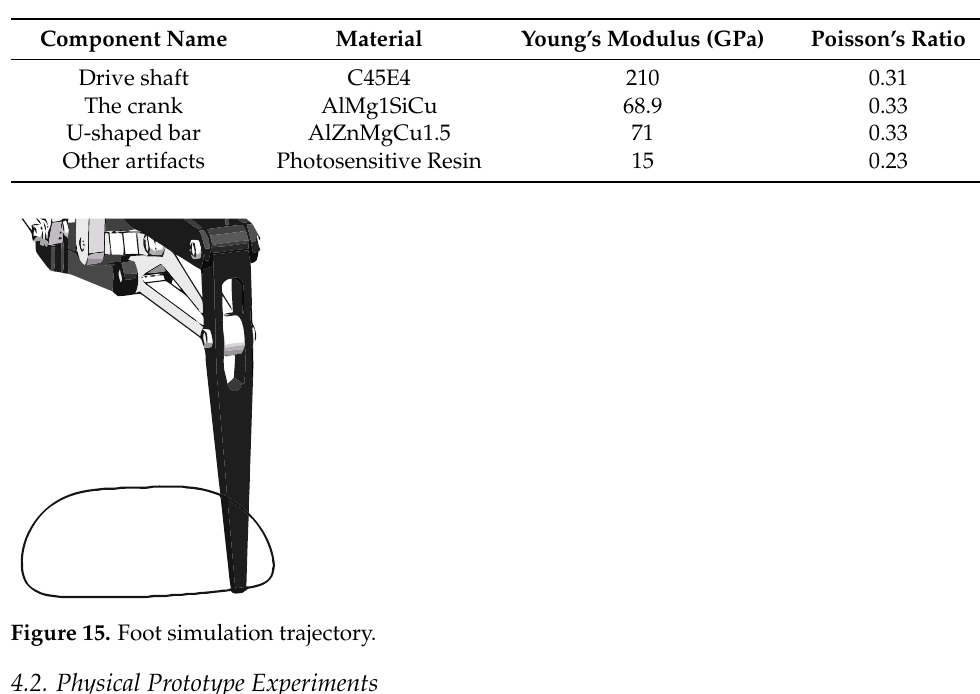
Figure 14. The result of the simulation experiment for a single leg. ( a ) The displacement graph of the foot end on the Y − axis . ( b ) The velocity graph of the foot end on the Y − axis . ( c ) The acceleration graph of the foot end on the Y − axis . Table 1. Material information of each component.